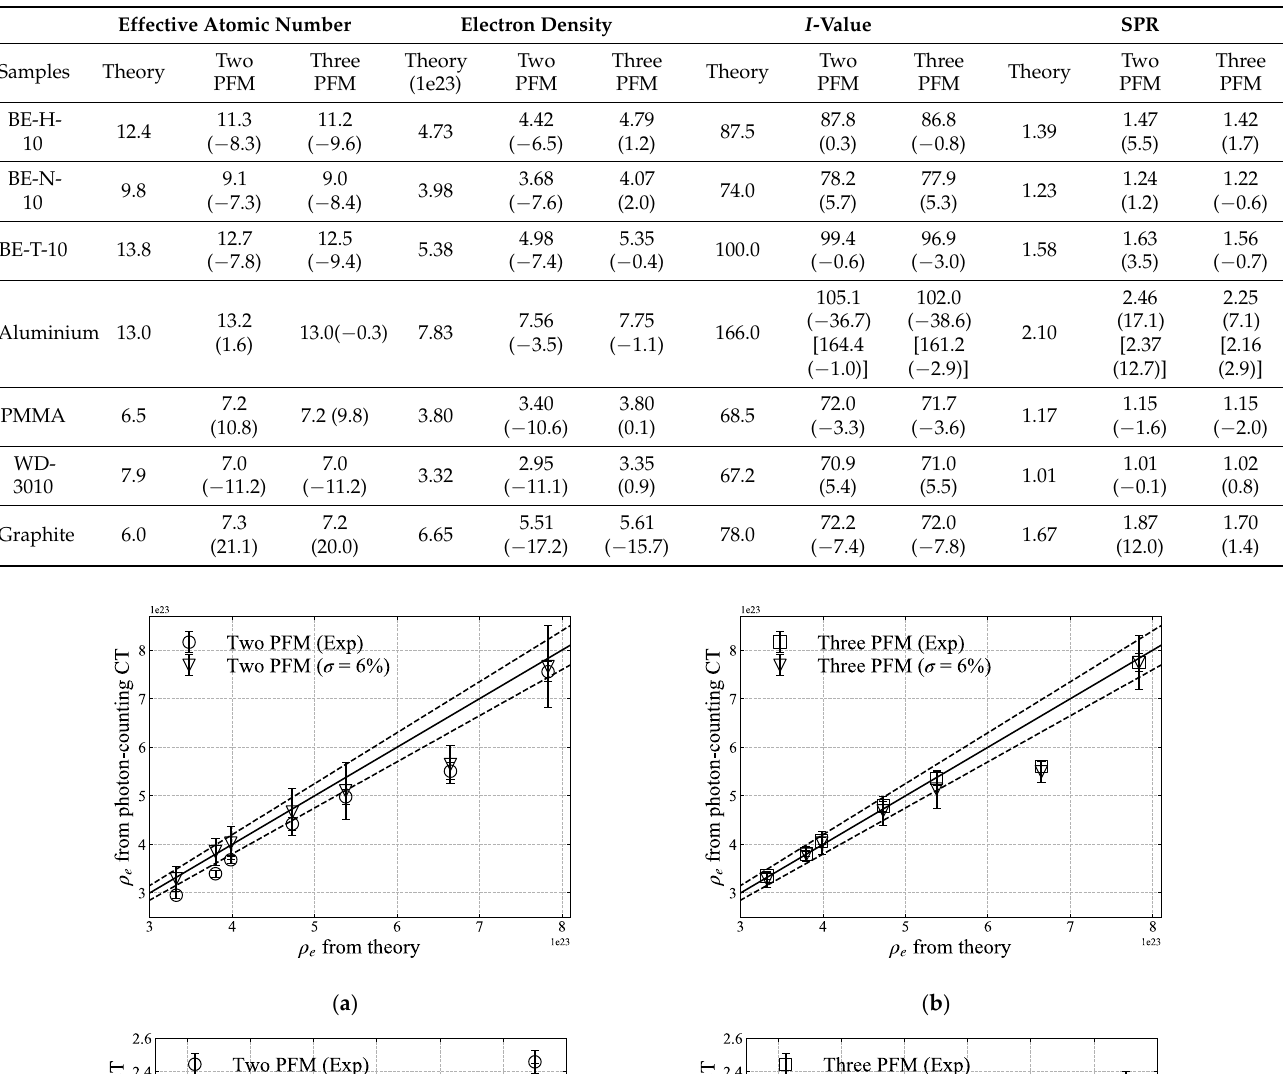
Table 2. Theoretical and experimental values for effective atomic number, electron density, I -value, and SPR. Relative error values are indicated in parentheses. Square brackets enclose the experimental values and relative errors when I -value and SPR are calculated from the obtained fitting curve using the PDG database in Figure 4.